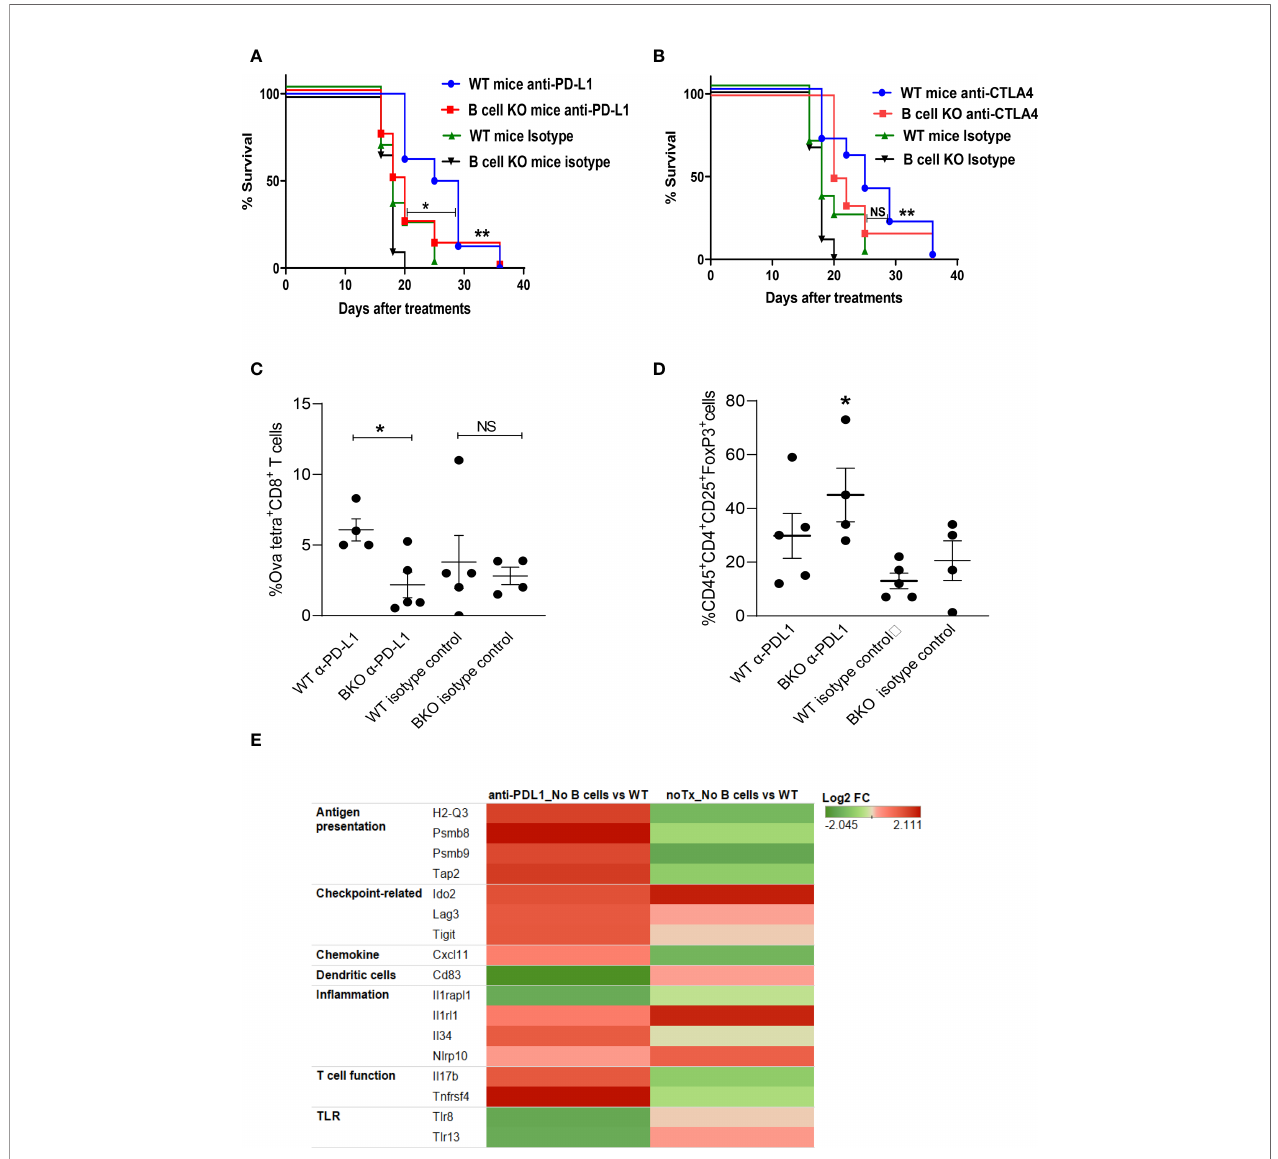
FIGURE 1 | B cells play a role in anti-PD-L1 but not anti-CTLA-4 – mediated anti-melanoma immunity. (A, B) WT and B cell KO (BKO) mice bearing B16.F10 tumors (400,000 cells/tumor) were treated with a -PD-L1 or a -CTLA-4 on days 4, 7, 10, and 14 after tumor cell inoculation. Kaplan-Meier survival curves, each with 8 to 10 mice per group. *P < 0.05, **P < 0.01, log-rank test. NS, not signi fi cant. (C) Mice bearing B16. Ova tumors were treated as indicated. Graph shows % of OVA- tetramer + CD8 + T cells in tumor (D) Tregs in WT and B cell KO (BKO) mice, after three days of the 3rd anti-PDL1 or isotype antibody treatment, n = 4 to 5 mice per group. *P < 0.05, unpaired Student ’ s t-test for tumor-speci fi c CD8 + T cells and one-way ANOVA for Tregs. (E) Heatmap (transcriptome analysis) of B16 melanoma from B cell depleted and WT mice, treated or untreated with anti-PD-L1. The graph depicts fold changes in genes expression in anti-PD-L1 treated B cell depleted vs WT mice and untreated B cell depleted vs WT mice (n=4